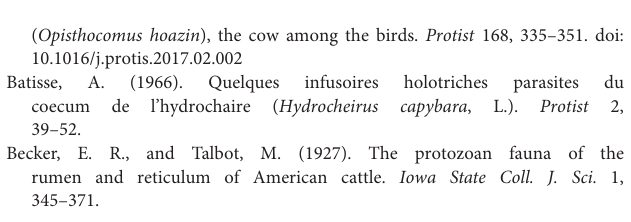
FIGURE S2 | Phylogenetic tree of trichostomatid ciliates (Ciliophora, Litostomatea, and Trichostomatia) based on 18S rRNA gene data. Spathidium papilliferum was chosen as out group. The black dots in the nodes indicate bootstrap (ML) or posterior probability (BI) values > 80/0.8. The scale bar corresponds to four substitutions per 100 nucleotides positions. TABLE S1 | Hosts where Trichostomatia ciliates were registered. MATERIAL S1 | Trichostomatid families and